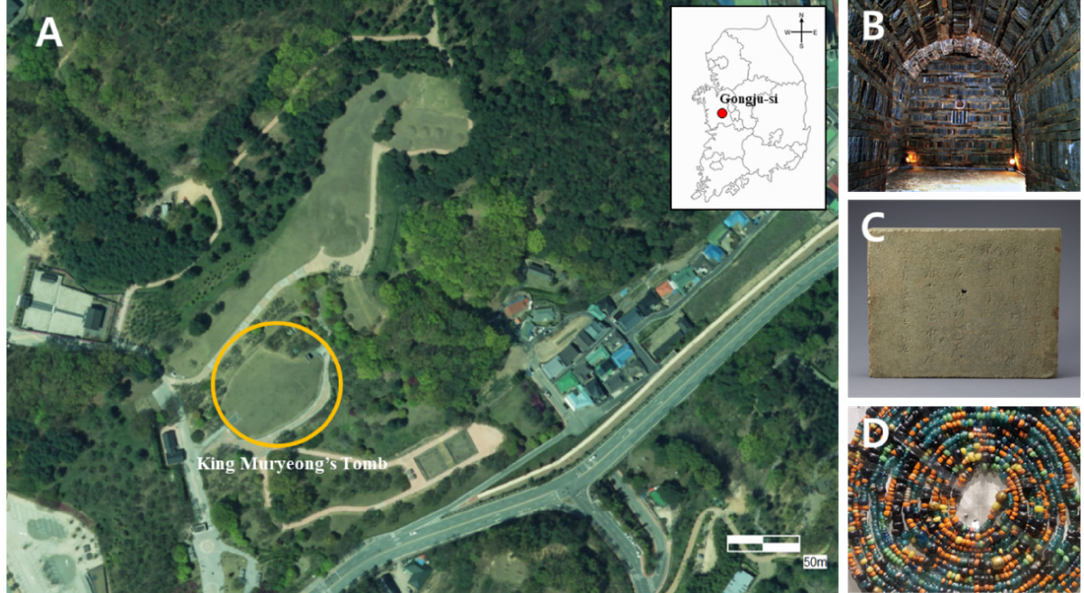
Figure 1. Location of the Tomb of King Muryeong selected for research; ( A ): Location of the ruins, ( B ): Brick tomb, ( C ): Memorial tablets with the date of creation of the cemetery, ( D ): Various colors of glass beads.